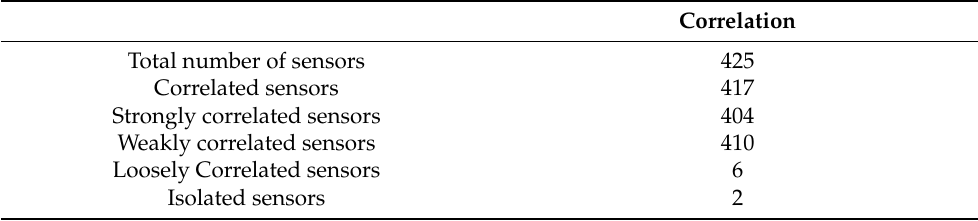
Table 1. Correlation of sensors based on the counted number of vehicles counted each hour of the day. Correlated sensors have distance ≤ 2000 m and more than 3 correlations. Strongly correlated sensors have distance ≤ 2000 m and more than 3 correlations with Pearson coefficient ≥ 0.8. Weakly correlated sensors have distance ≤ 2000 m and more than 3 correlations with Pearson coefficient ≥ 0.7. Loosely correlated sensors have distance ≤ 2000 m and 1 or 2 correlations.